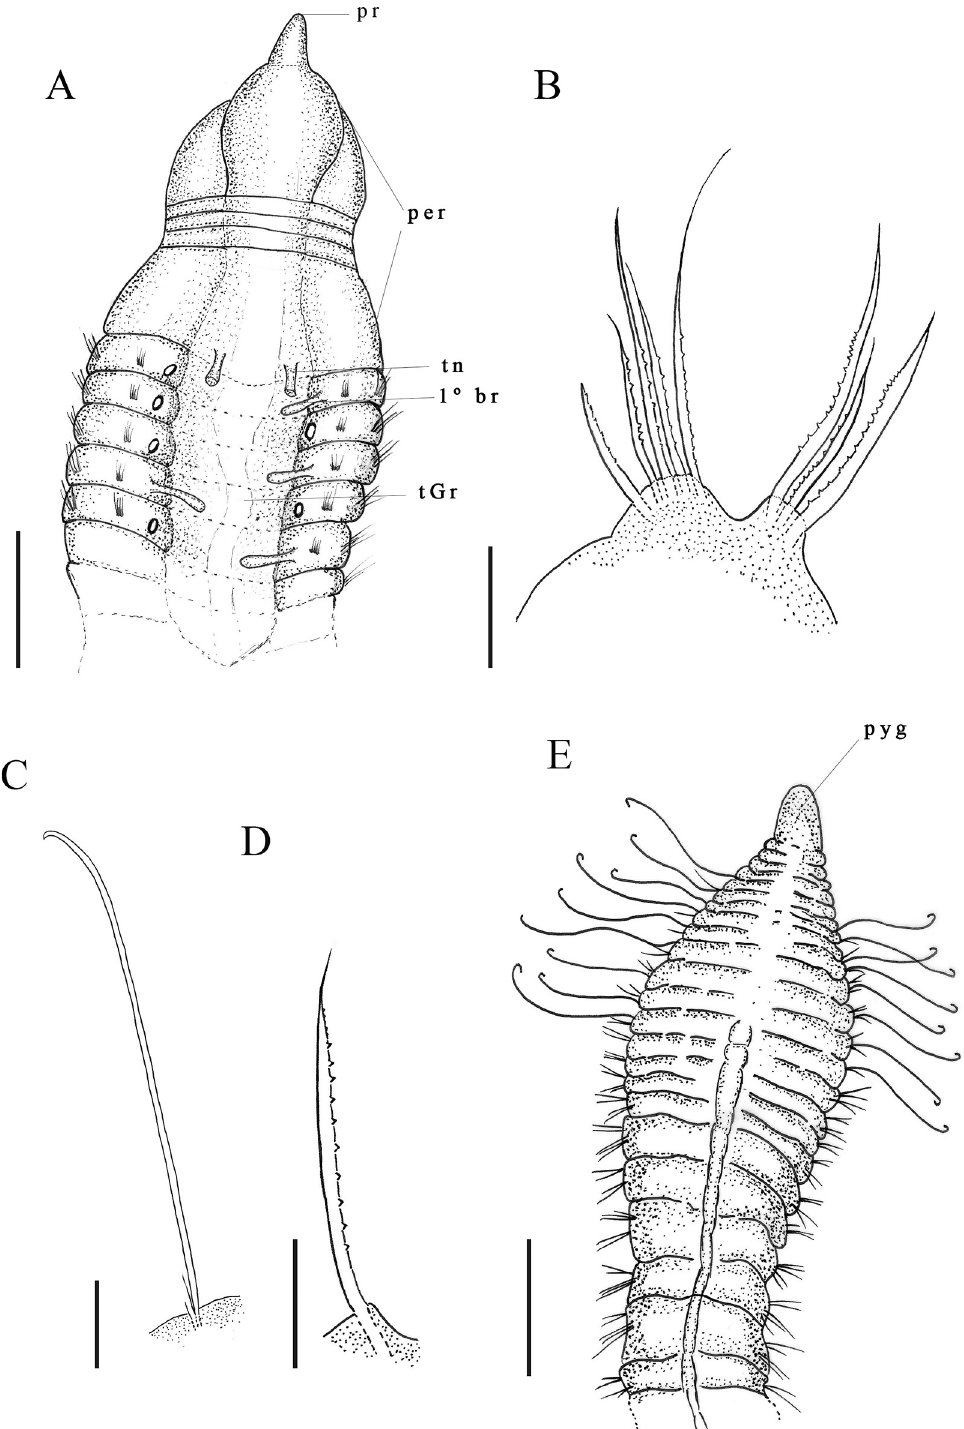
Fig 3. Kirkegaardia blakei sp. nov. (A) anterior end, dorsal view; (B) posterior parapodium, anterior view; (C) notopodial seta with long curved tips; (D) neuropodial denticulated capillary; (E) posterior end, dorsal view. A–E, (MNRJP-002971). Scale bars: 100 μ m (A and E); 200 μ m (B–D). Type locality. Atlantic Ocean: Campos Basin (Brazil). Habitat. Sandy sediments, 38 and 683 m depth. Distribution. Presently known only from Atlantic Ocean: Campos Basin (Brazil). Methyl Green. No pattern, stain not